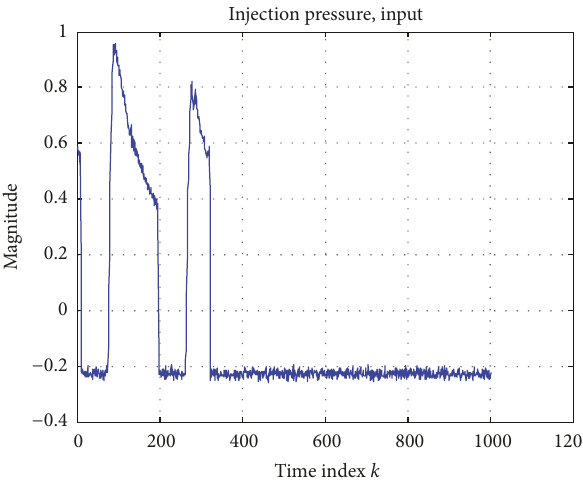
Figure 14: Injection pressure plot for flow coefficient 0.51, validation data.